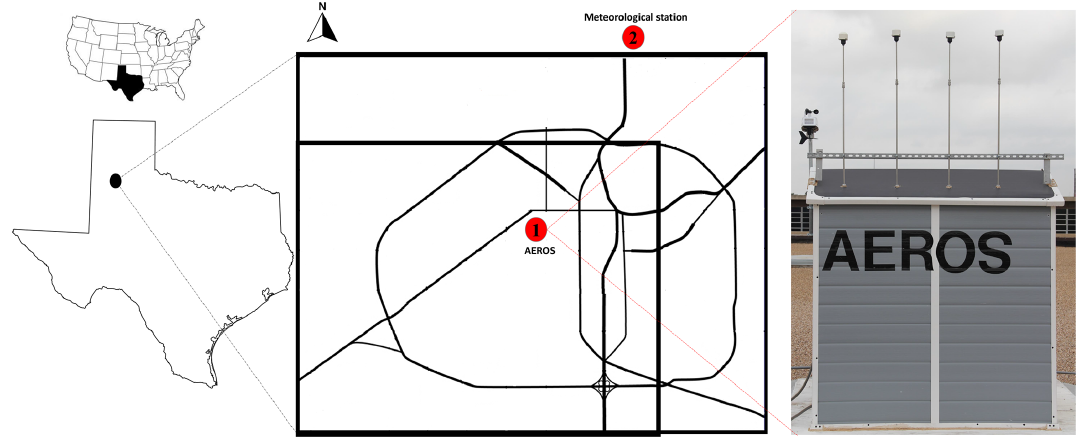
Figure 1. Location of AEROS (1) and the meteorological station (2) in the Southern High Plains region of West Texas. The photo shows the AEROS aerosol measurements unit.